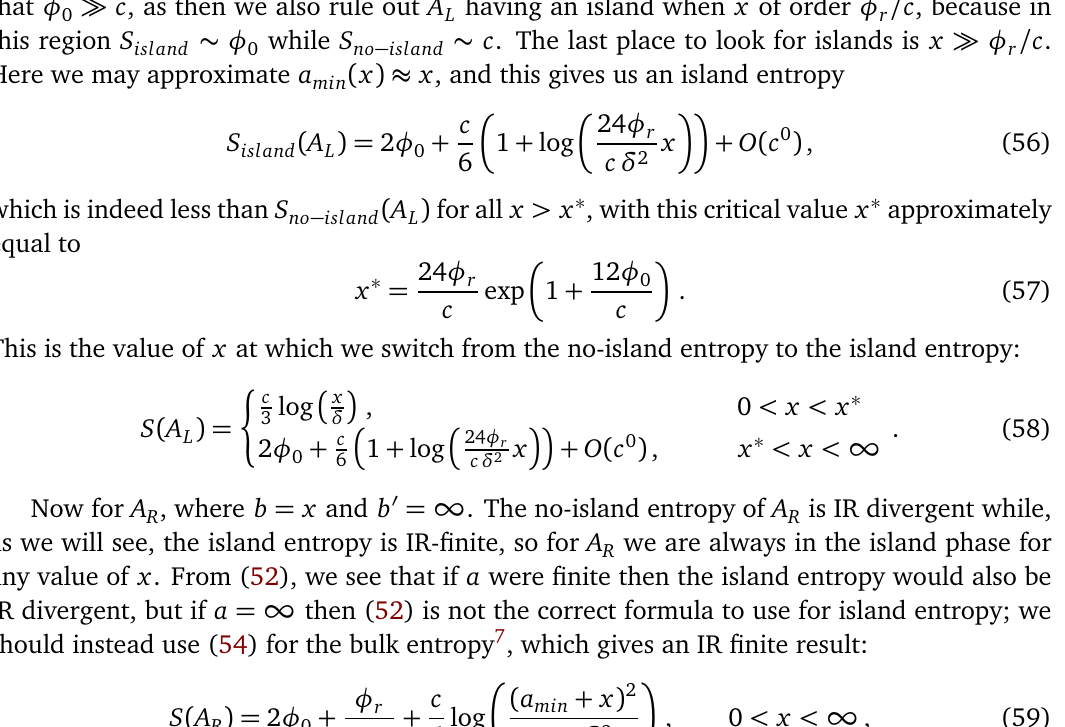
coupled to a flat non-gravitating region. The 2 and its island I . Right: The L and A the regions whose entropy we L R ( x ) A